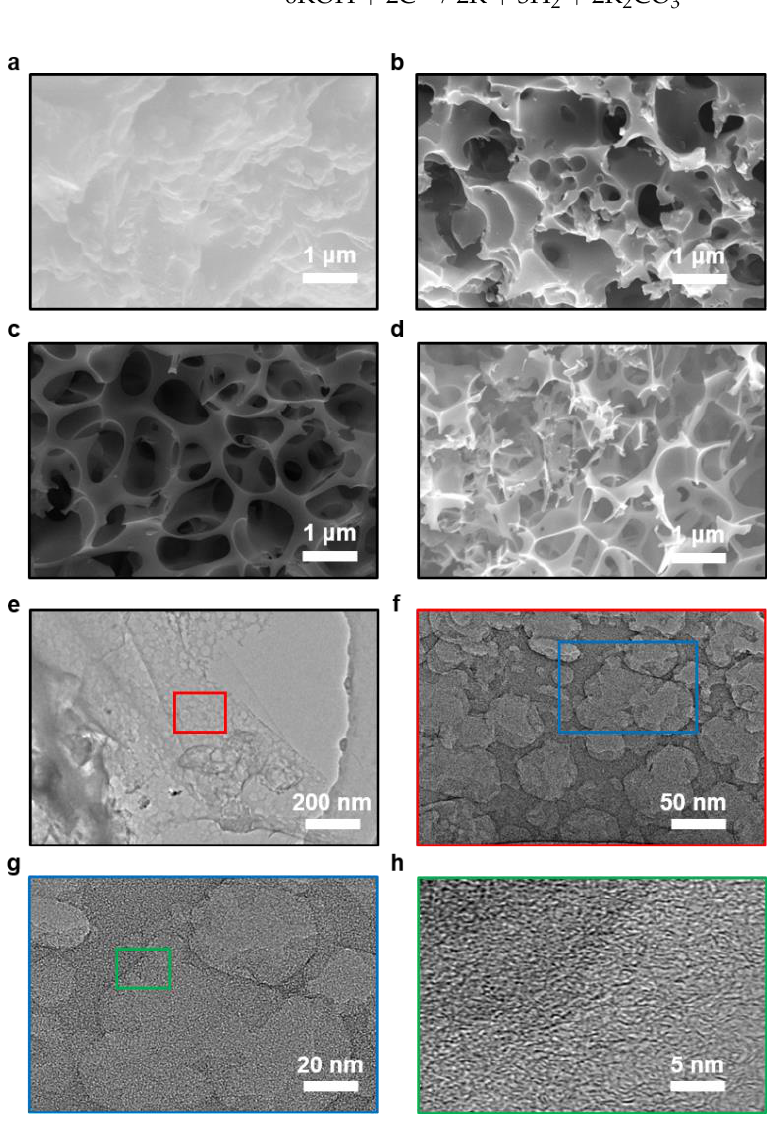
Figure 2. SEM images of the porous carbon electrodes: ( a ) TAC.; ( b ) TAC2; ( c ) TAC3; ( d ) TAC4; ( e – h ) TEM images of TAC3.